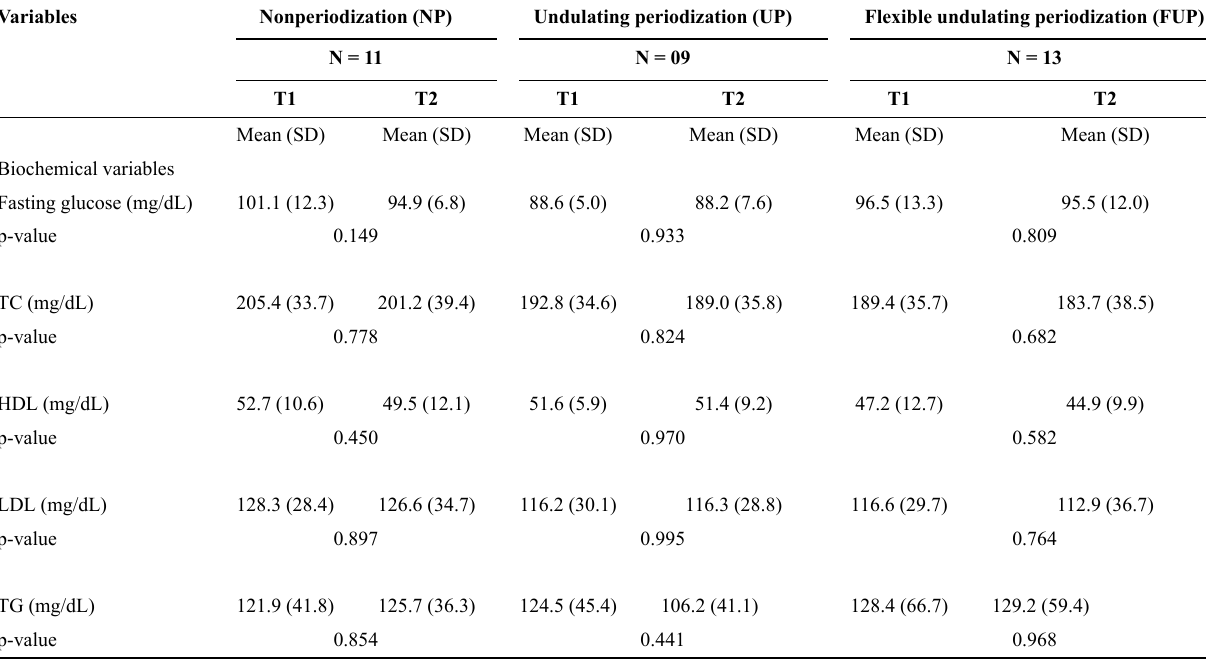
Table 2 - Distribution of the participants regarding biochemical variables, by physical training group and evaluation time.